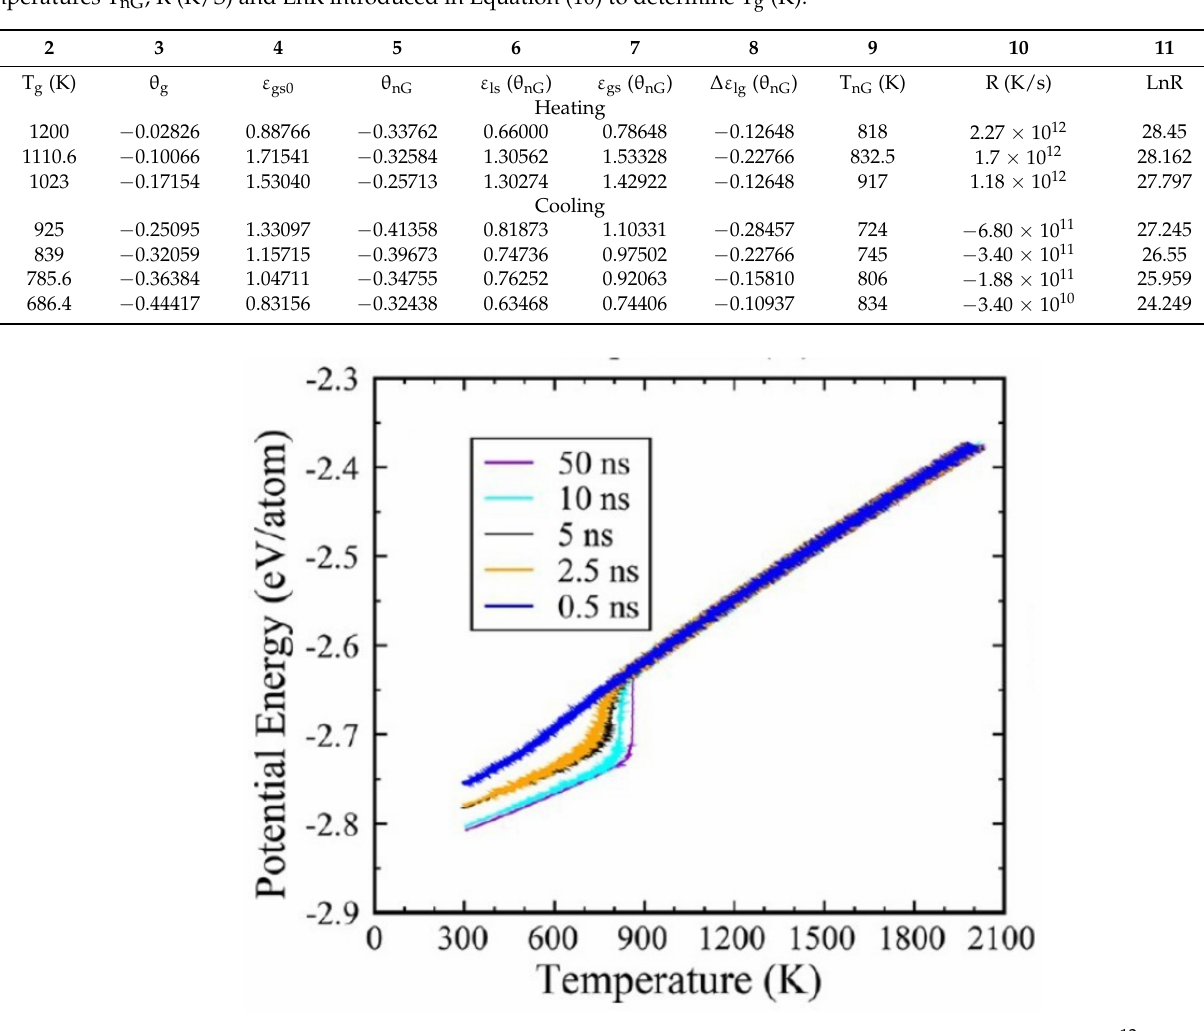
Figure 10. Cooling of a 256,000 atoms system with various cooling rates. − 3.4 × 10 12 (0.5 ns), transformation temperatures are predicted in Table 3-cooling. Reprinted with permission from